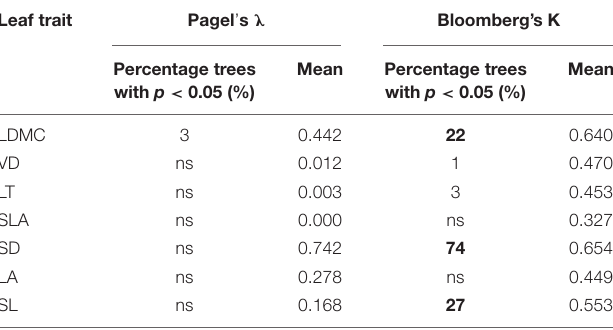
TABLE 1 | Phylogenetic signal of the palm leaf functional traits, across the phylogeny of the local community. Leaf trait Pagel ’ s λ Bloomberg’s K Percentage trees with p < 0.05 (%)